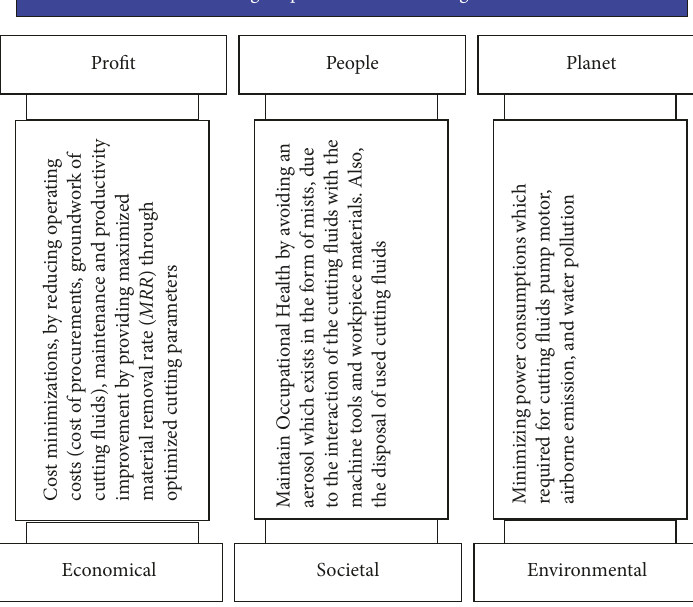
Figure 1: Pillars of product sustainability and the corresponding